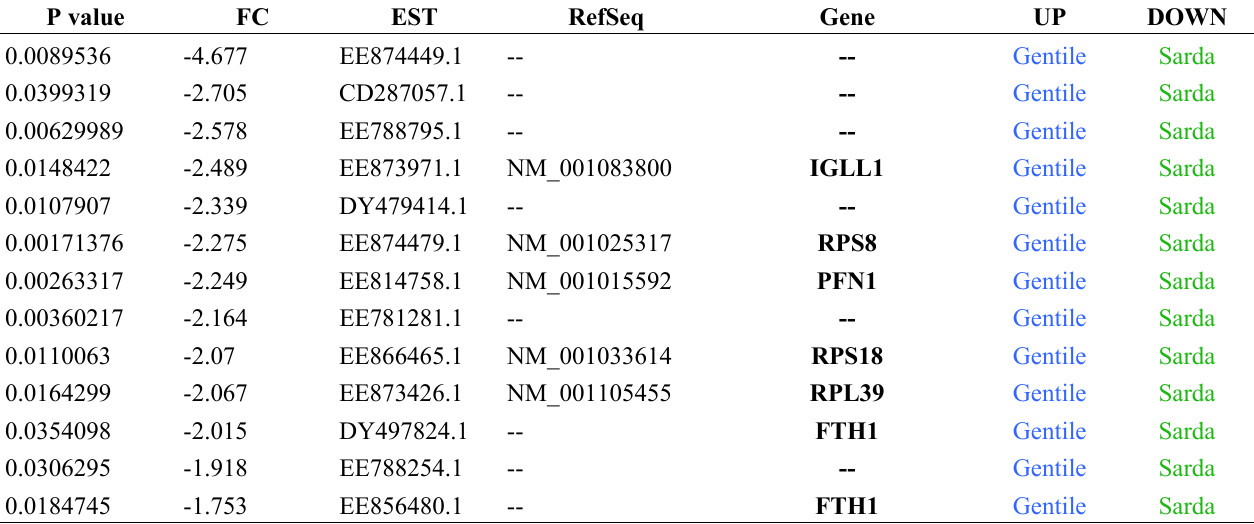
Table 2. Differentially expressed genes, stage